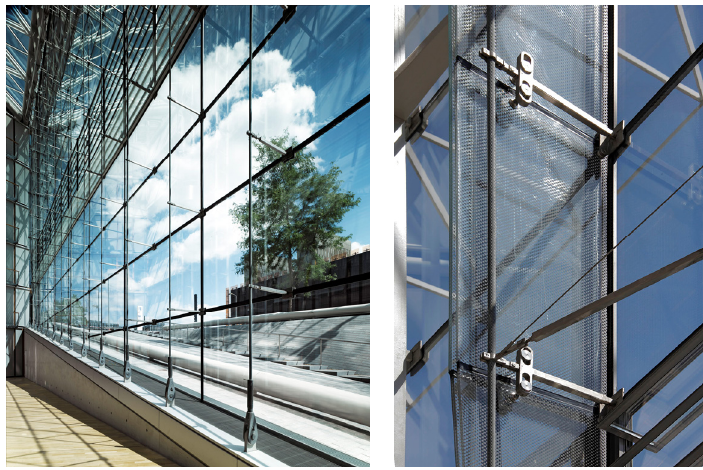
Figure 7: European Investment Bank, Luxembourg